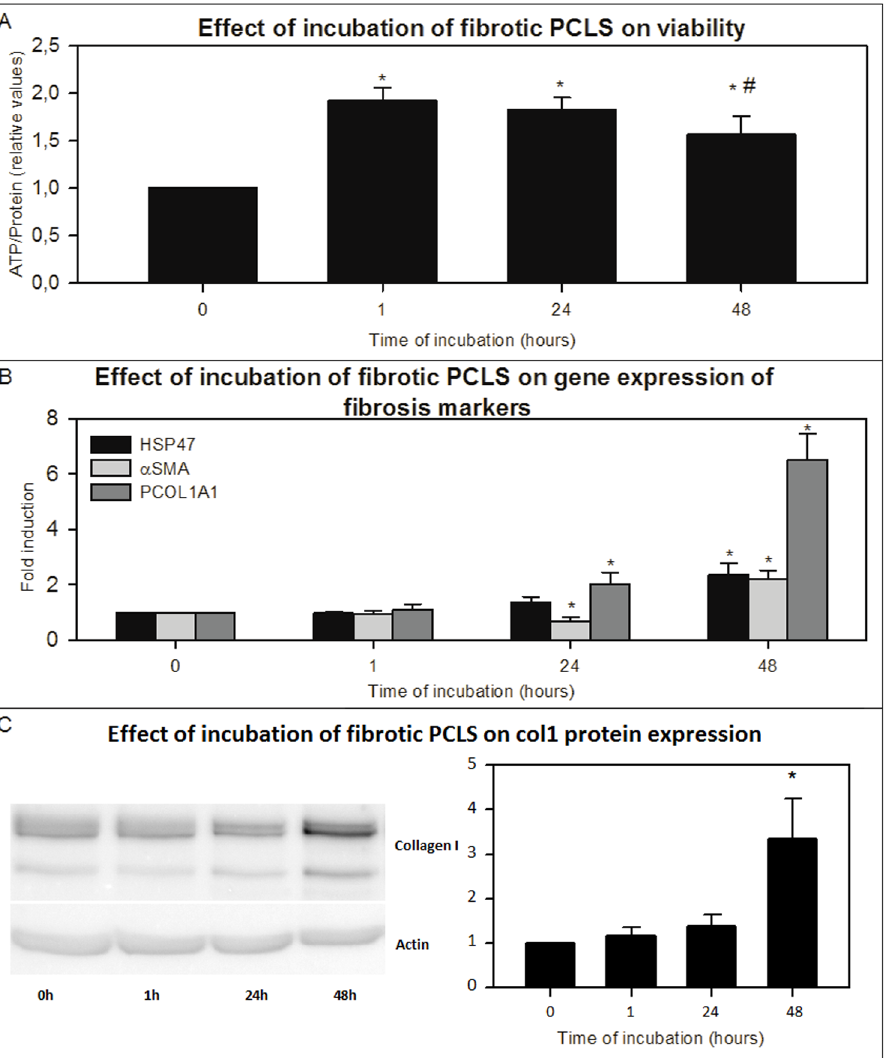
Figure 1. The effect of incubation of fPCLS on viability, gene expression of fibrosis markers and collagen 1 protein expression. The effect of incubation up to 48 hours on the viability (A) (n=12), on the gene expression of fibrosis markers Hsp47 , a Sma and Pcol1A1 (B) (n=13) and on the collagen 1 protein expression measured by western blot (pictures are from a representative experiment) (C) (n=10) of fibrotic PCLS from livers of BDL rats. Error bars represent standard error of the mean (SEM). *p , 0.05 vs 0 hours. # p , 0.05 vs 1 hour.